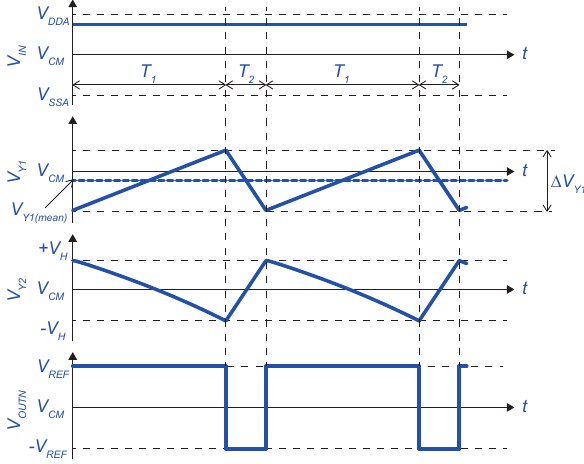
Figure 3. Timing diagram of the asynchronous sigma delta modulator with a constant